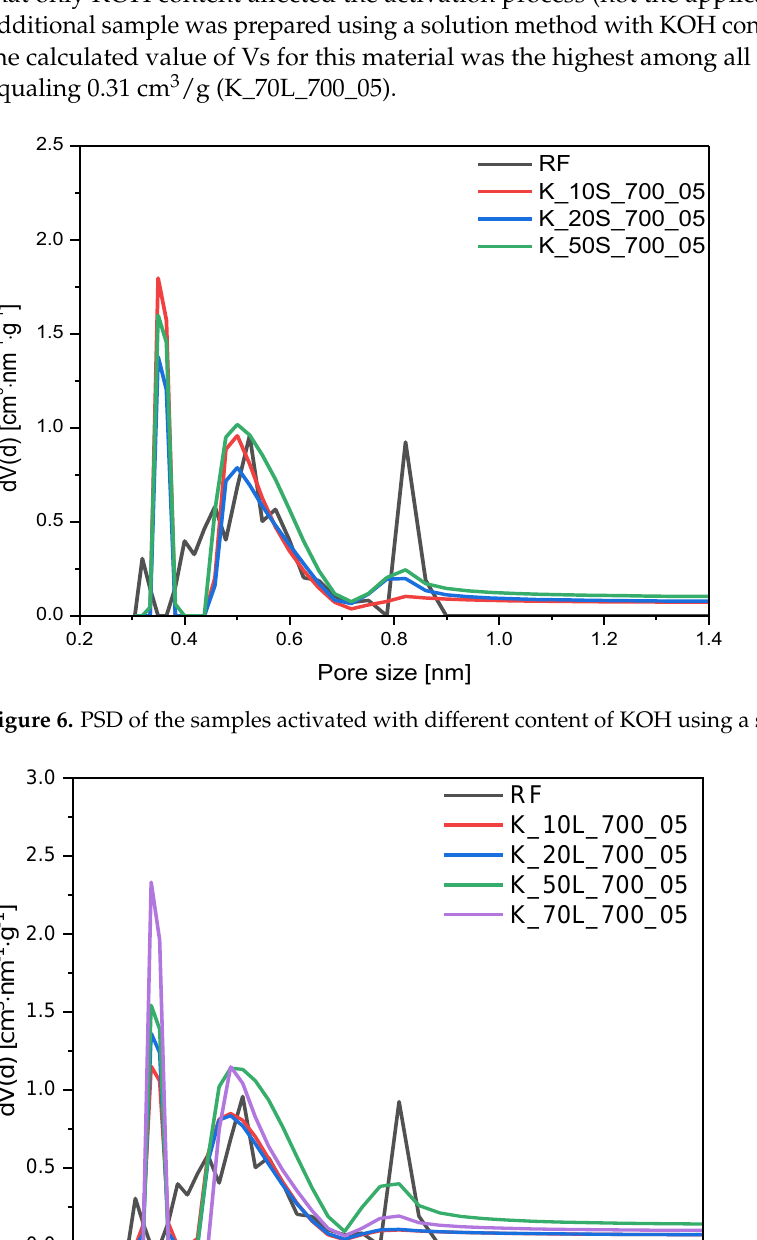
Figure 7. PSD of the samples activated with different content of KOH using solution-based